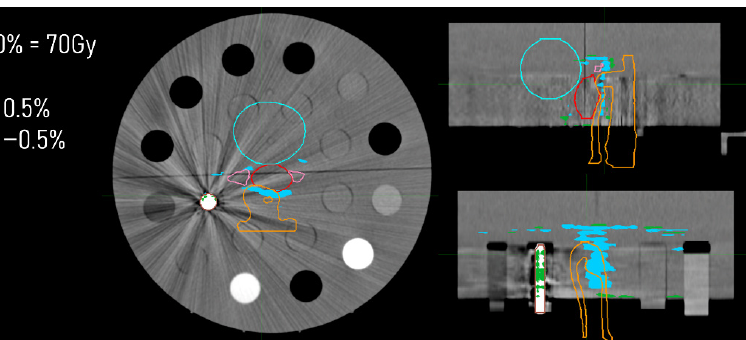
Figure 8. Absolute maximum differences in dose, expressed as percentage of the dose to the prostate (100% = 70 Gy), between the dose distribution calculated on the DD reconstruction of the CT scan of the Cheese phantom acquired with the stainless ‐ steel insert at 120 kVp and the dose distribution calculated on the ideal phantom simulating the presence of the stainless ‐ steel phantom SRP). Green and blue shading corresponds to maximum differences of − 0.5% and 0.5%, respectively. The analysis was made with MIM Maestro ® and differences are reported on the DD reconstruction of the Cheese phantom acquired with the stainless-steel insert at 120 kVp (axial section on the left, sagittal section at the upper right corner, and coronal section at the lower right corner).